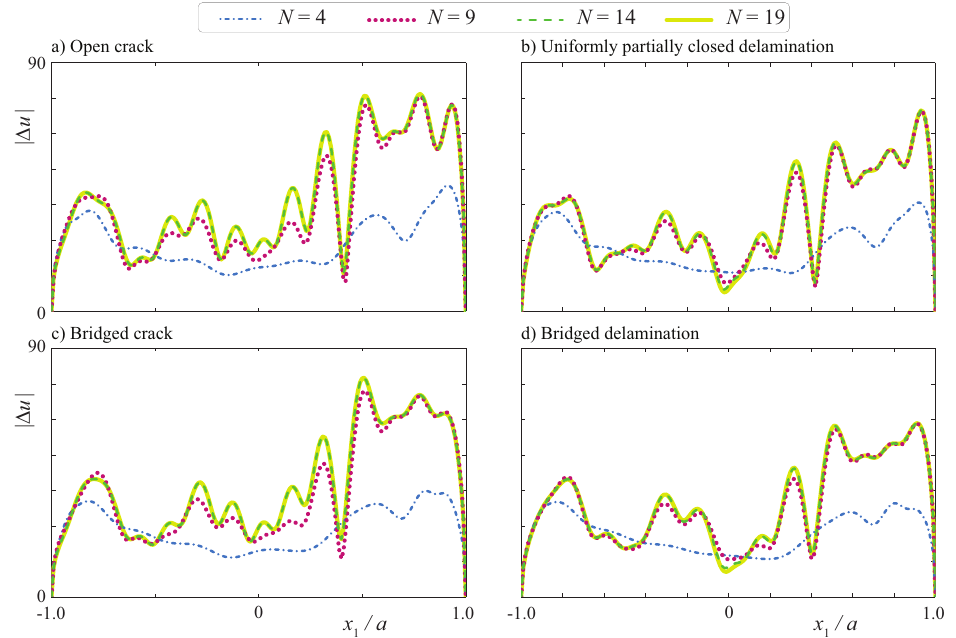
Figure 7. Amplitudes of the COD |(cid:52) u ( x 1 ,0 ) | of circular delaminations for a transverse wave incident at 30 ◦ angle to plane x 3 = 0 and 90 ◦ angle to plane x 2 = 0: two half-spaces made of aluminium and polycarbonate, k T 2 a = 20.